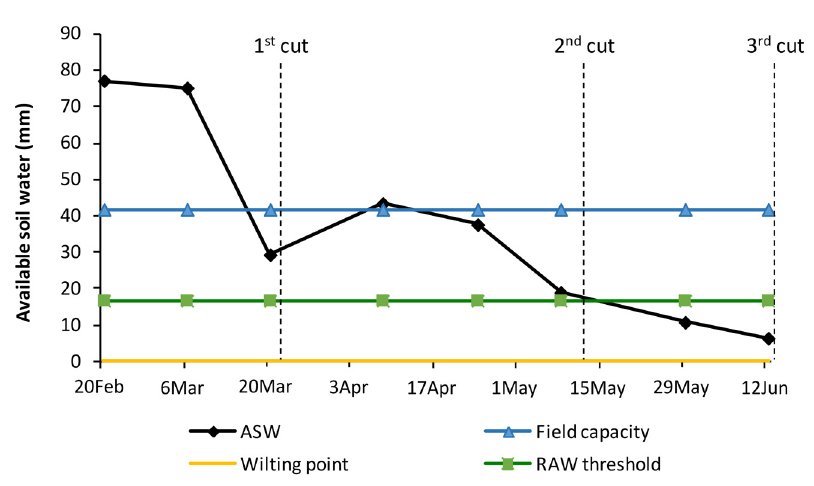
Figure 3. Soil water availability during the crop growing